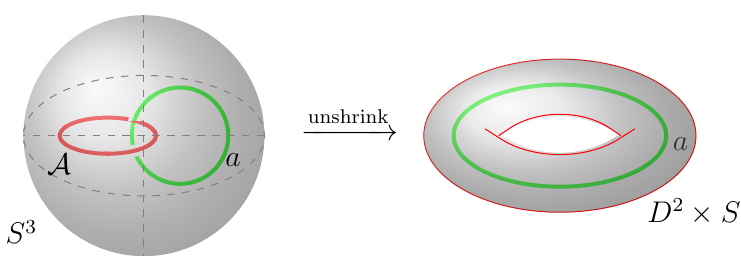
Figure 3: The Hopf link between a and can be evaluated to ( SZ ) . On the other 0 a A hand, replacing by an empty tube gives a solid torus with a wrapping the non- A contractible cycle, which can be evaluated to the dimension of the Hilbert space on D 2 with an insertion of a , i.e. Z 0 a